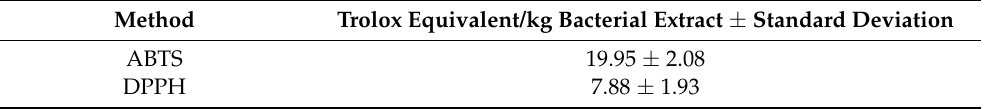
Table 3. Antioxidant evaluation through ABTS and DPPH